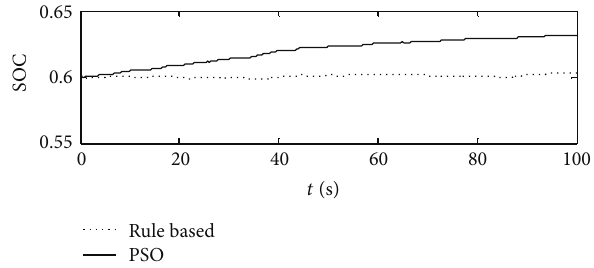
Figure12:ThecomparisonsofSOCalterationbetweenPSOoptimal control and rule-based